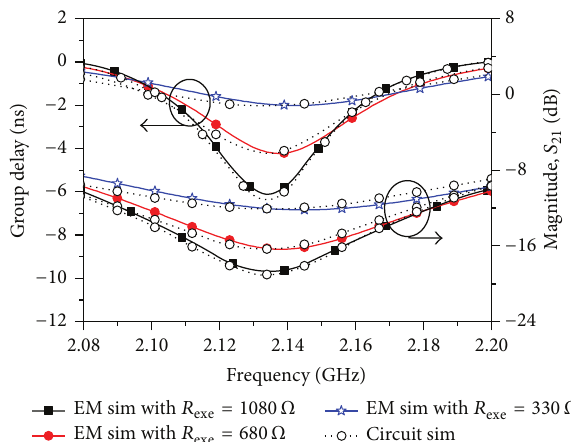
Figure 4: Single-stage NGD networks: (a) simulated and measured group delay and magnitude characteristics and (b) measured return loss